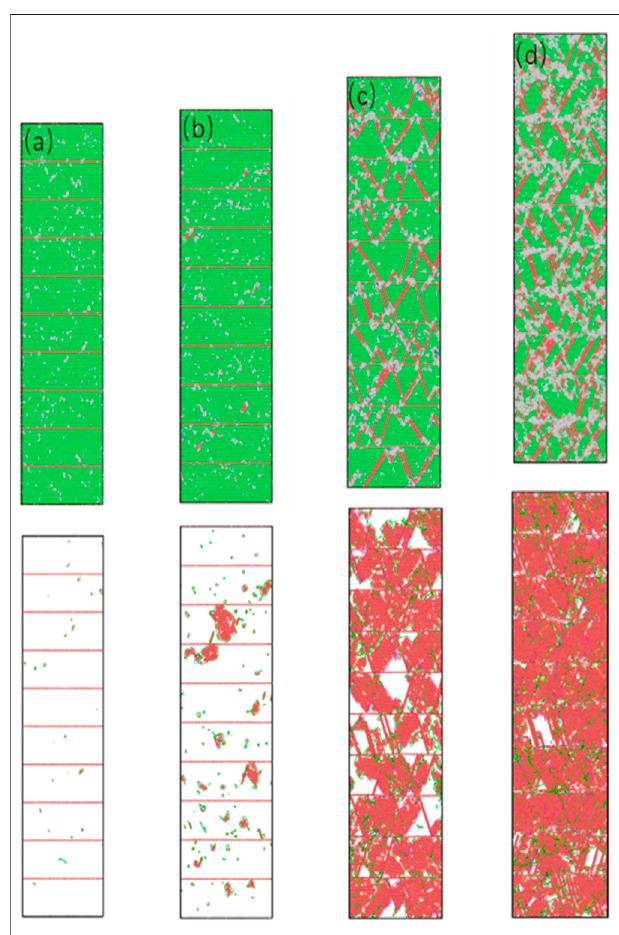
FIGURE 7 | The microstructure of nt-HEAs ( λ = 6.78 nm) under different strains (A) 2.4%, (B) 2.9%, (C) 10%, and (D) 15%.